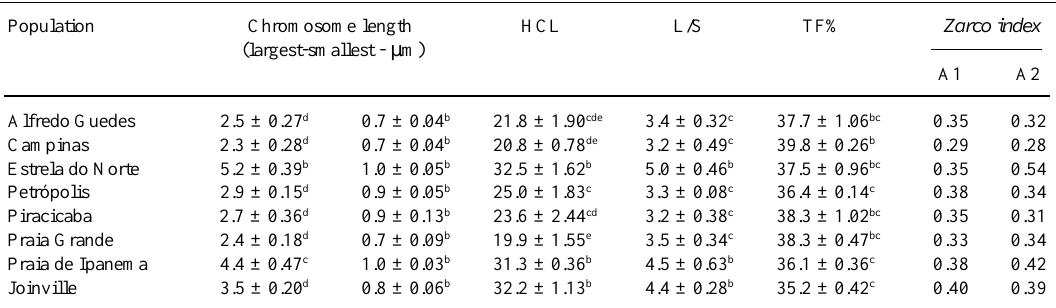
Table II - Chromosome length ( m m), haploid chromosome length (HCL), ratio of longest/shortest chromosomes (L/S), and karyotype symmetry using total form (TF%) and Zarco index of cytotypes of Mikania micrantha , seven with 2n = 36, and one with 2n = 42.